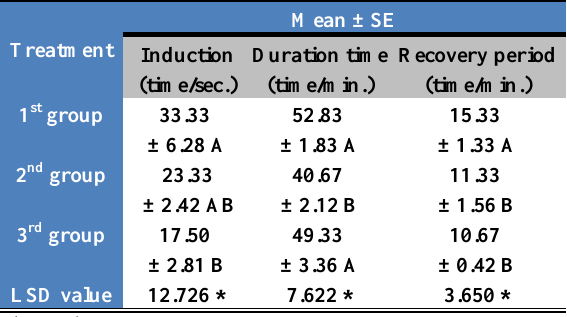
Table, 1: shows the induction, recovery and duration times.